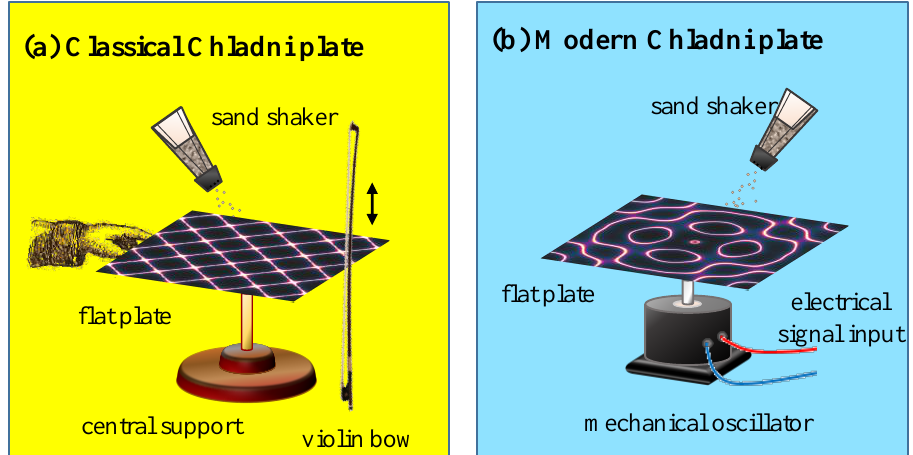
Figure 1. Experimental setups of ( a ) classical and ( b ) modern Chladni plates.